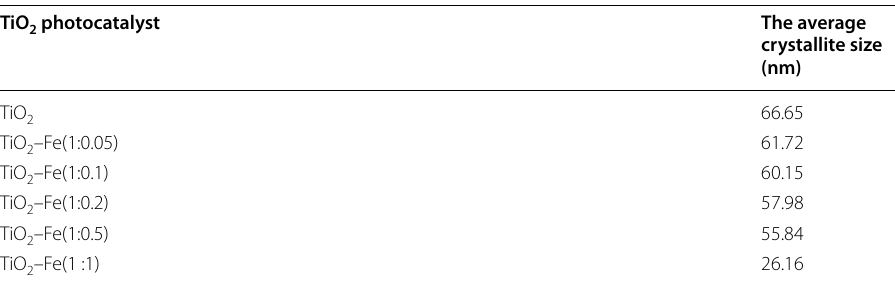
2 crystallite size (nm)